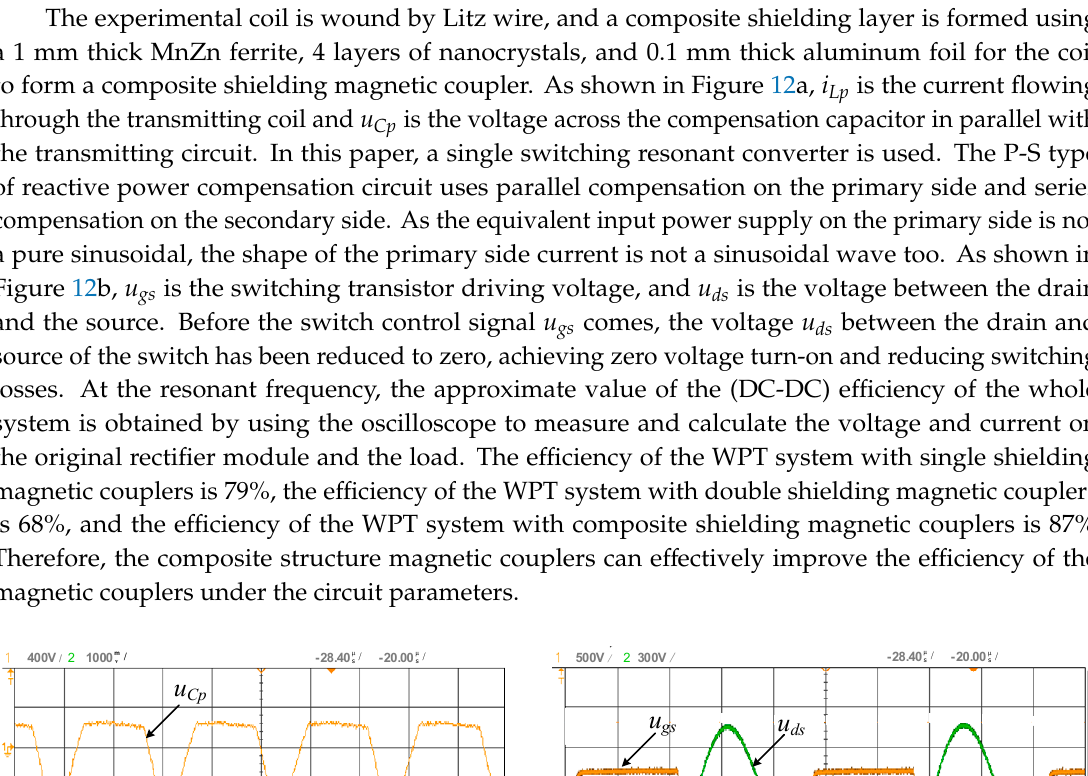
Figure 11. E xperimental setup of the WPT system.